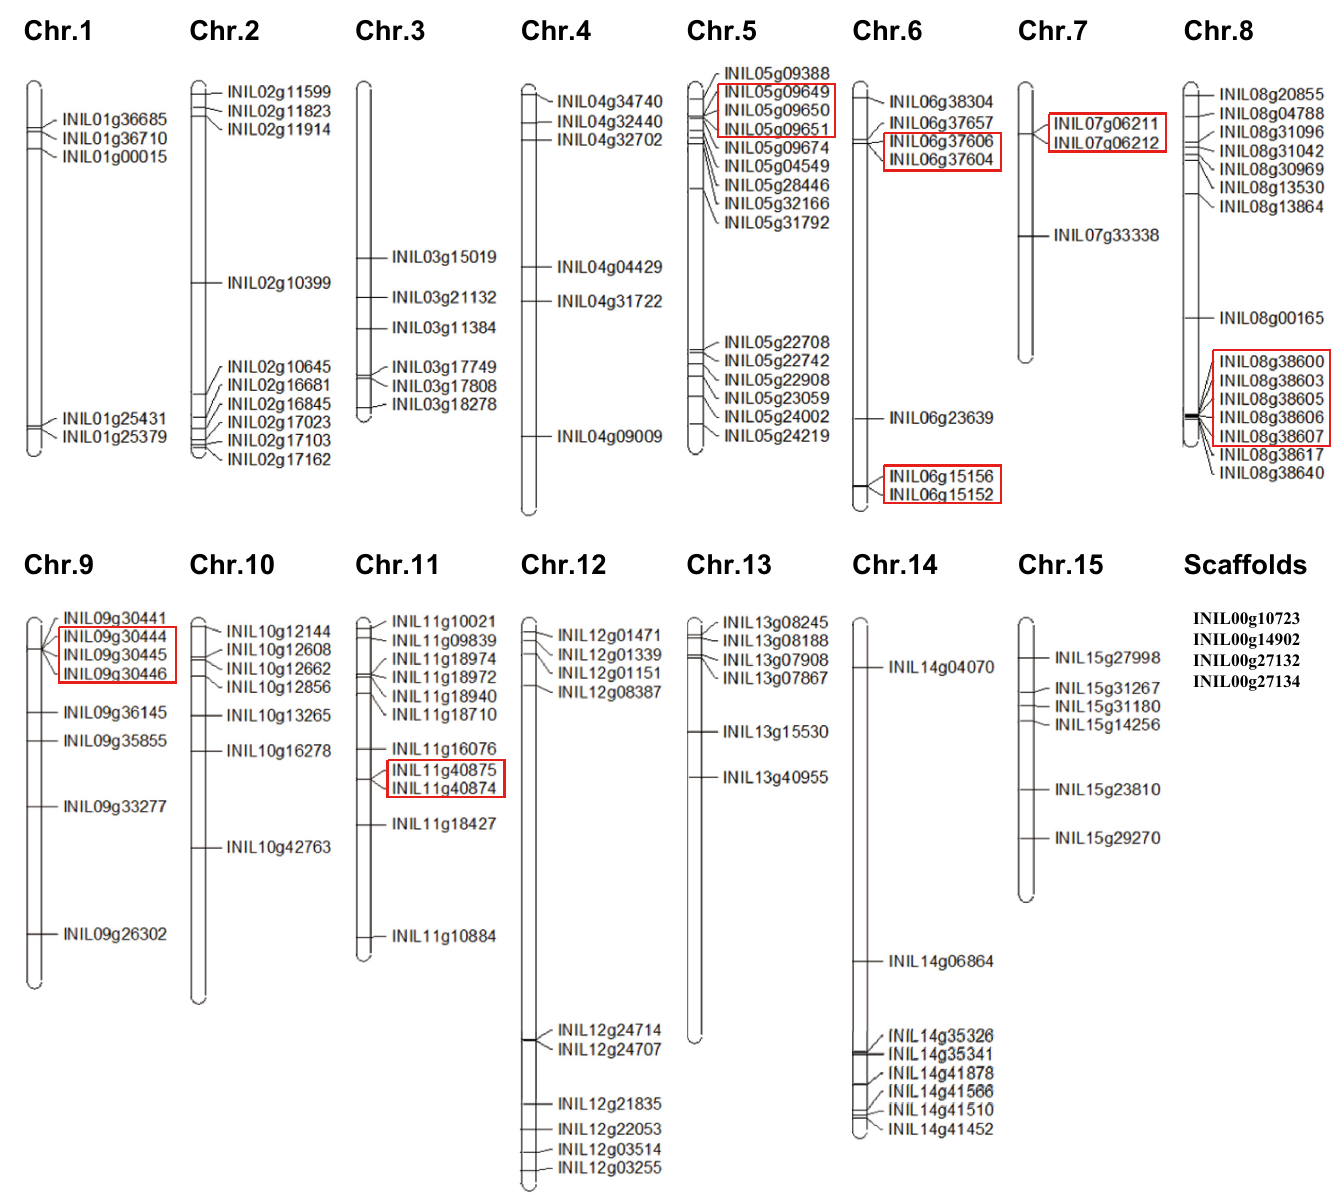
Fig 4. Chromosomal locations of R2R3-MYB genes of Japanese morning glory. The chromosomal positions of the Japanese morning glory R2R3-MYB gene were mapped according to the Asagao Genome Database. A total of 123 of the R2R3-MYB genes are mapped on the 15 chromosomes, and four genes are mapped on the scaffolds. Red boxes indicate duplicated gene clusters on the